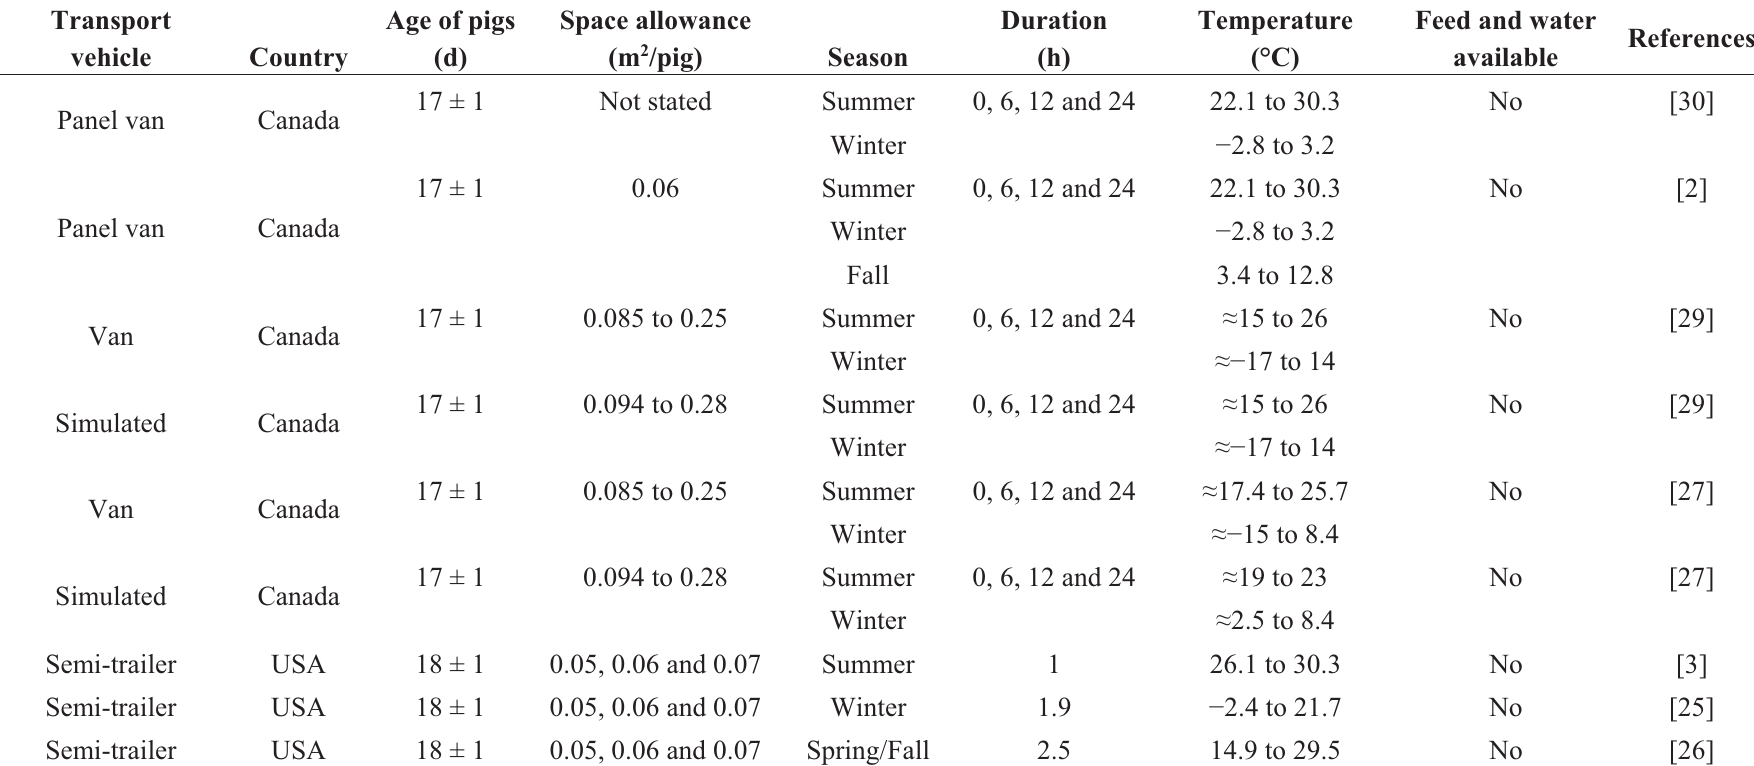
Table 1. Summary of studies investigating the effect of transport on pigs at